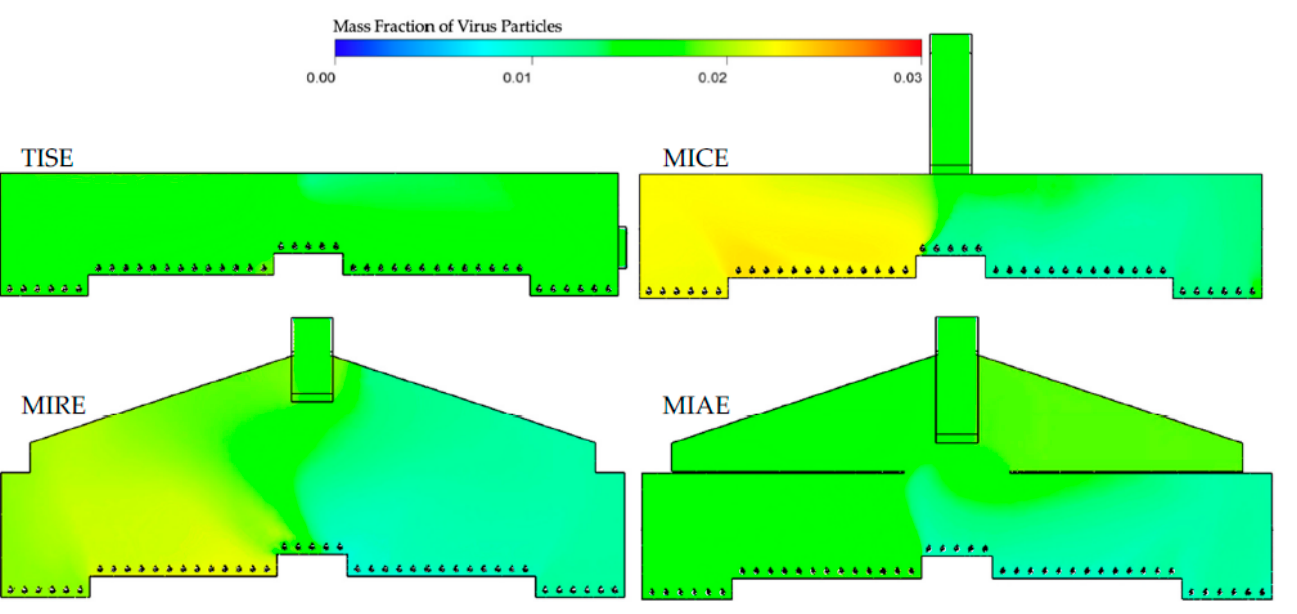
Figure 7. Indoor mass fraction contours of virus particles in four models (TISE, MICE, MIRE, and MIAE) at the cross-sectional reference plane, CP-F.